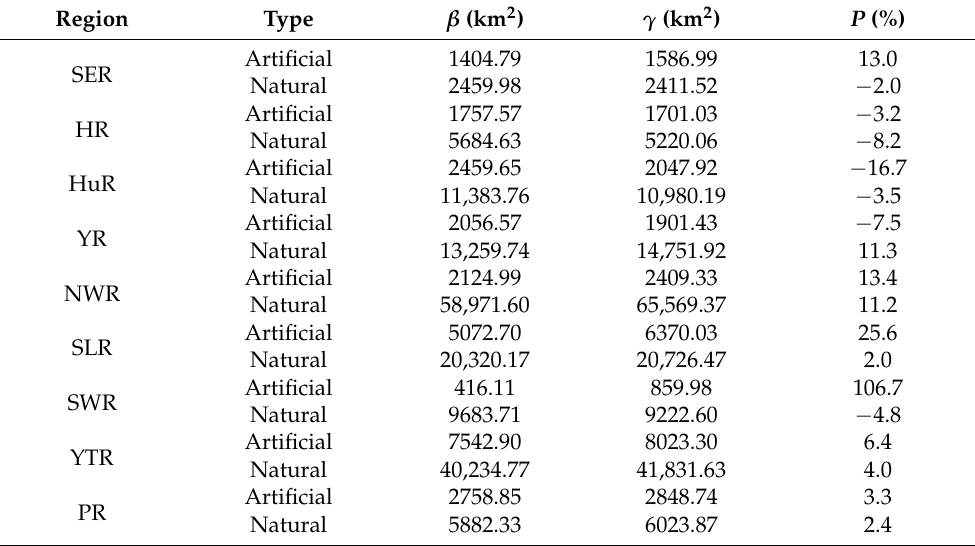
Table 4. Variation trends of artificial and natural water bodies in each basin from 2015 to 2020 compared with 2000 to 2005.